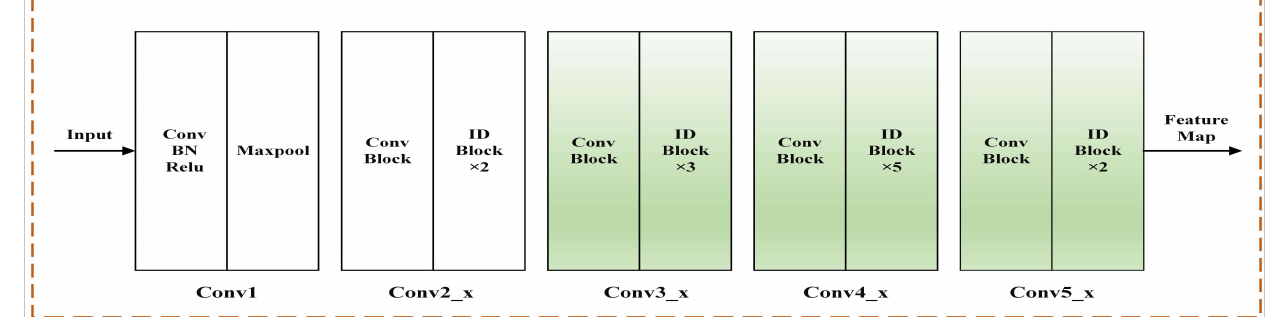
Figure 3. ResNet50 backbone network